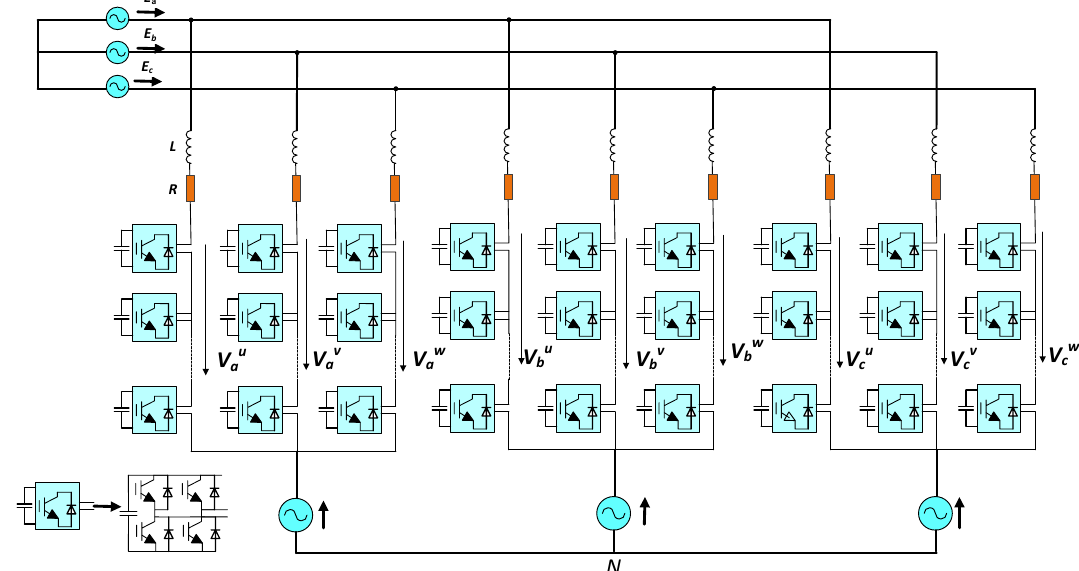
Fig. 18 Structure of matrix converter